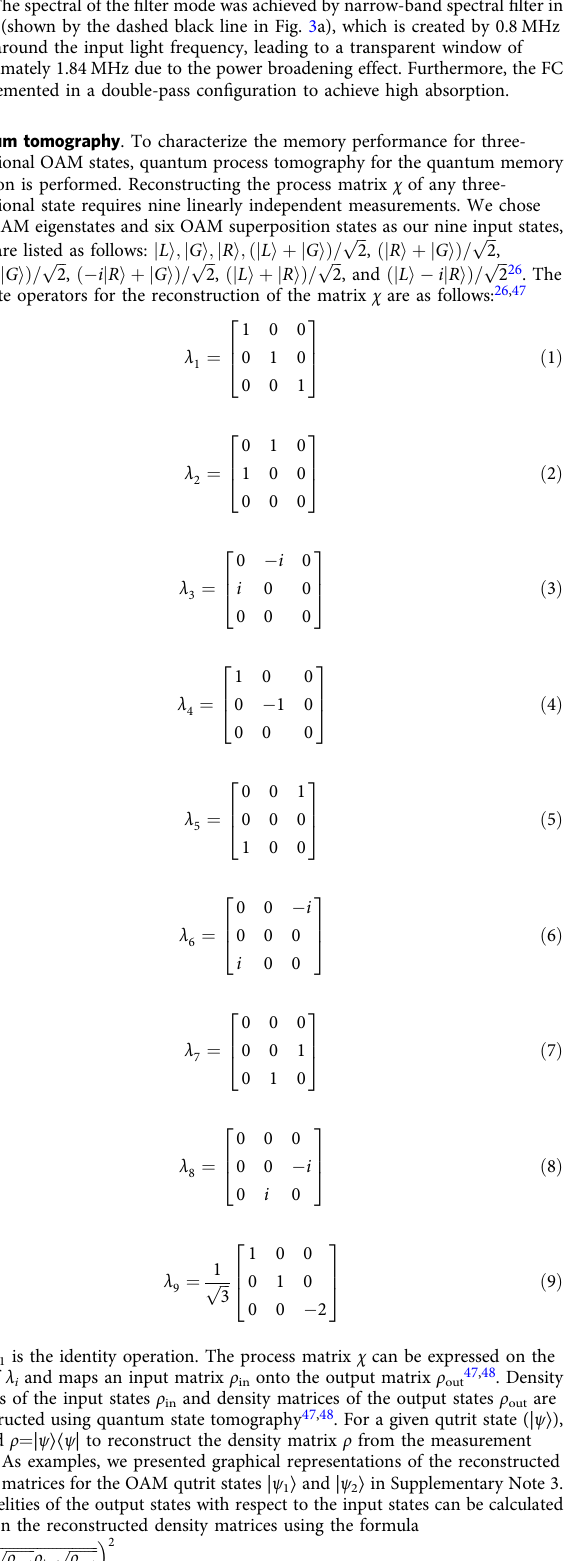
(cid:1) (cid:1) (cid:3) The fi delity for the output mode of ψ 1 f 1 t 1 ; f 1 t 2 is a little lower than the others because of the less photon counts in each output caused by the temporal splitting operation. The error bars for the fi delities correspond to one standard deviation caused by the statistical uncertainty of photon